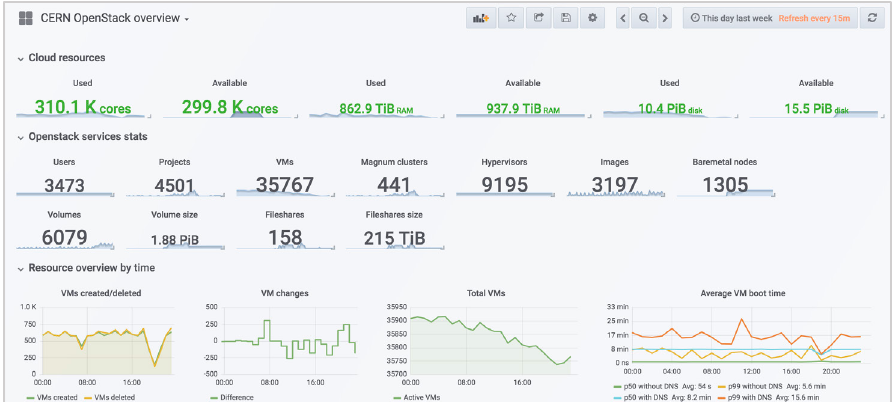
Fig. 3. Example of Dashboard of the Cloud OpenStack Service